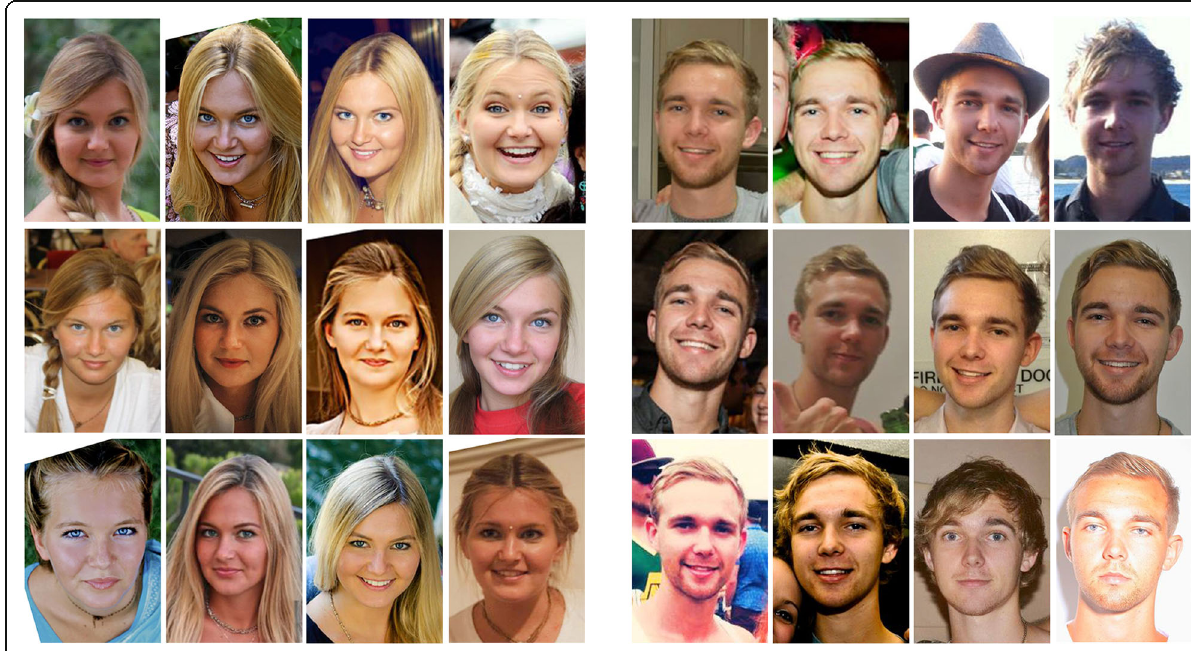
Fig. 1 Example image sets provided by two participants in the Profile Image Dataset. Each participant selected the most and least likely image to be used in three social media contexts (see Fig. 3a), then rated the likelihood that each image would be used in each context, before rating trait impressions. They then repeated this procedure with an unfamiliar face. Images used with permission and the full Profile Image Dataset is available online in Additional file